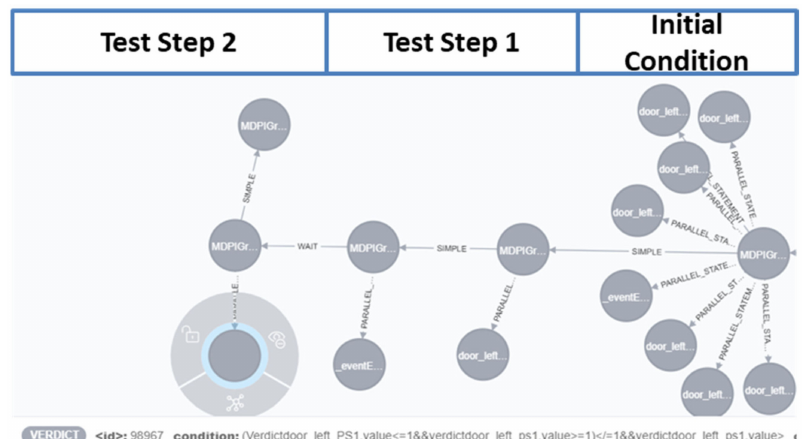
Figure 15. Test case as graph G I.